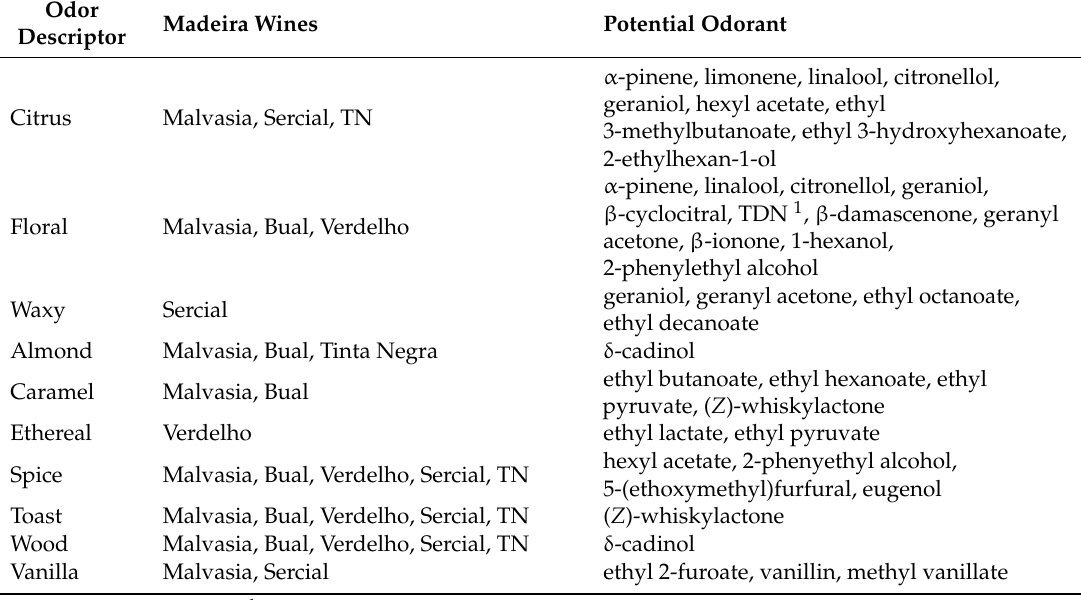
Table 3. Potential impact odorants of Madeira